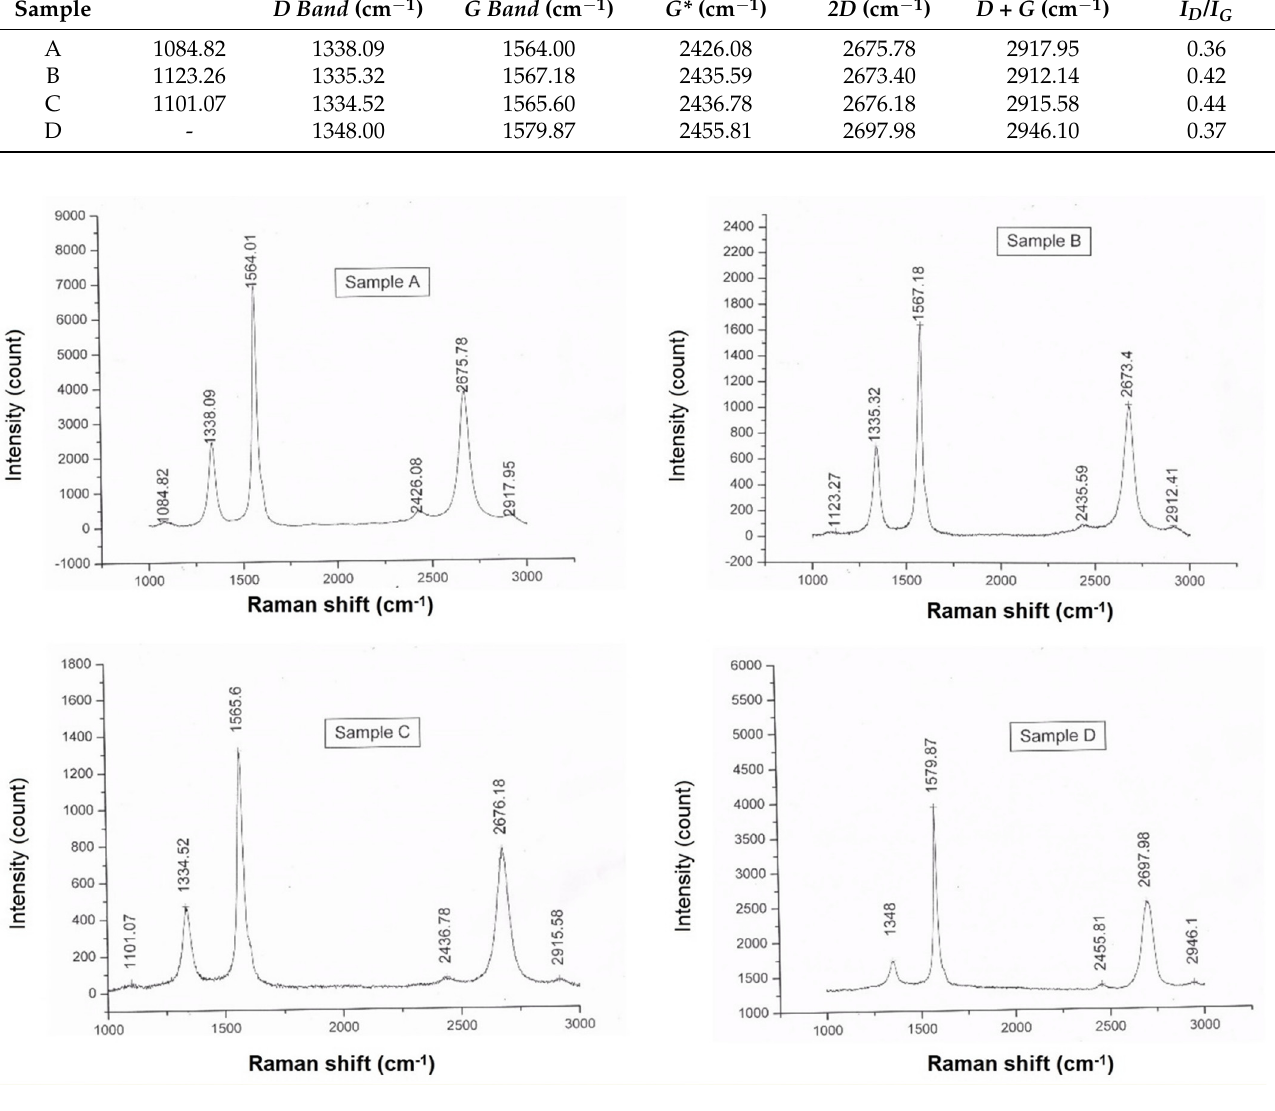
Figure 3. Raman spectra of ( A ) MWCNT-COOH, ( B ) MWCNT-CONOHME, ( C ) MWCNT- CON(OH)CO(Me), and ( D ) MWCNT-CON(OH)COPh. A comparison of the D bands in the starting material, MWCNTCOOH (A), and the MWCNT-CONOHMe (B), MWCNT-CONOHCOMe (C), and MWCNT-CONOHCOPh (D) compounds reveals that the D bands of MWCNT-CONOHMe (B), MWCNT-CONOHCOMe (C), and D shifted to lower wavenumbers by 3, 2, and 4, cm − 1 , respectively. This was possibly caused by the increase in sp 2 -hybridized carbon in these functionalized products and the effect of elec- tron withdrawal. Additionally, the intensities of the D bands of the MWCNT-CONOHMe (B) and MWCNT-CONOHCOPh (D) compounds were noted to decrease compared to that of compound MWCNTCOOH (A). On the other hand, the intensity of the D band of MWCNT-CONOHCOPh (D) was notably increased compared to that of compound MWCNTCOOH (A). The I D / I G ratios of the starting material, MWCNTCOOH (A), and the MWCNT-CONOHMe (B), MWCNT-CONOHCOMe (C), and MWCNT-CONOHCOPh